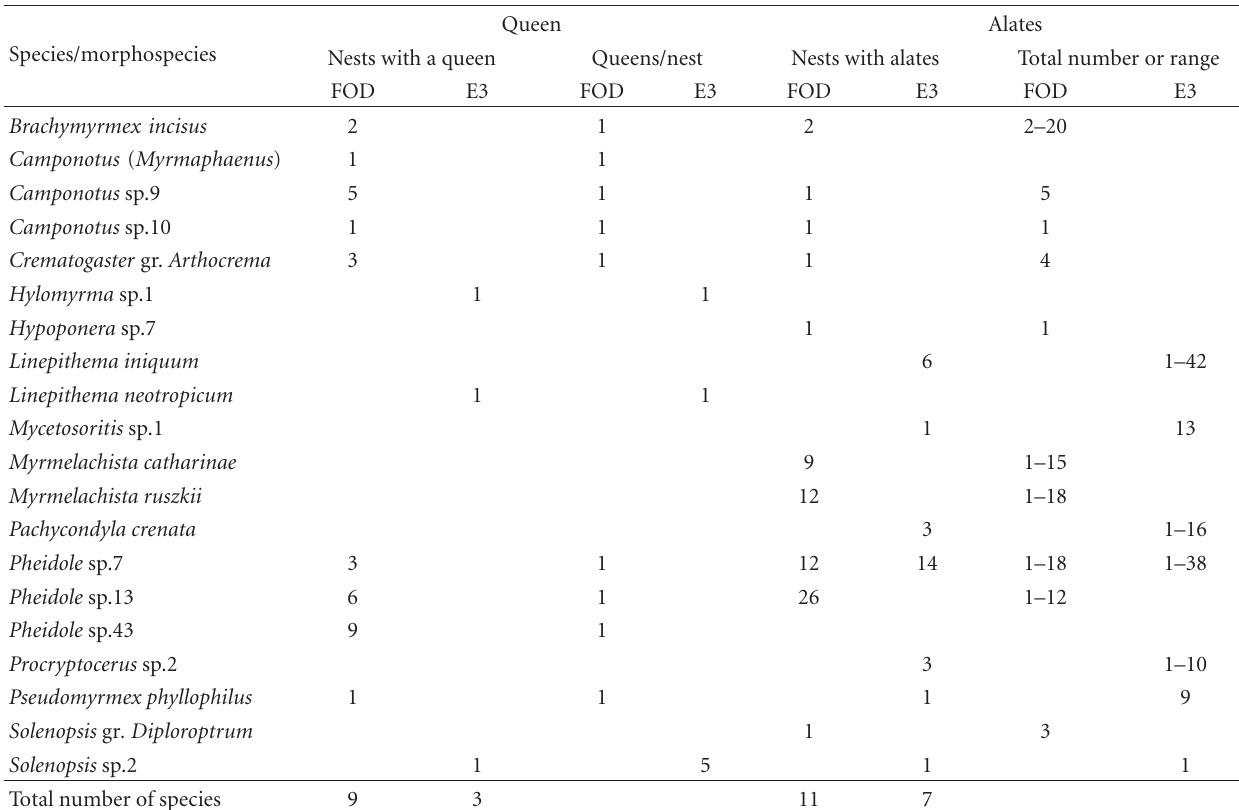
Table 2: Presence of a queen and alates according to the recorded species in twigs and forest type. Queen Species/morphospecies Nests with a